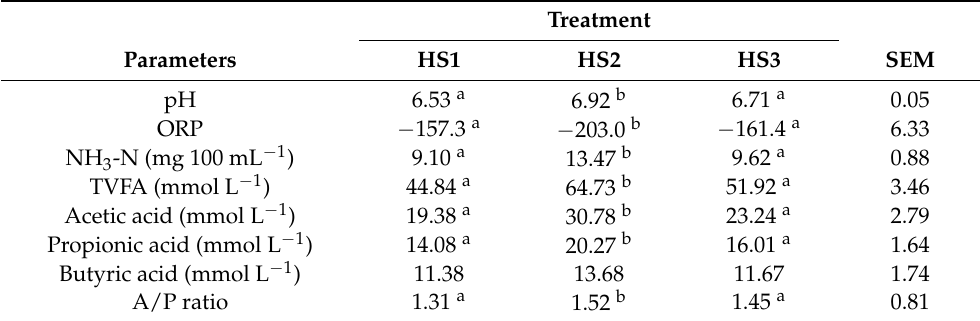
Table 5. The rumen fermentation parameters of the heat-stressed goats supplemented with Clostrid- ium butyricum